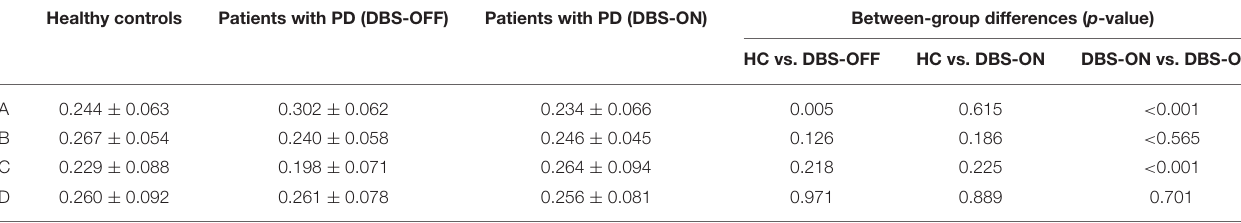
TABLE 3 | Contribution of microstate classes A to D, and results from comparison between groups with an independent samples t -test and a paired samples t -test. Healthy controls